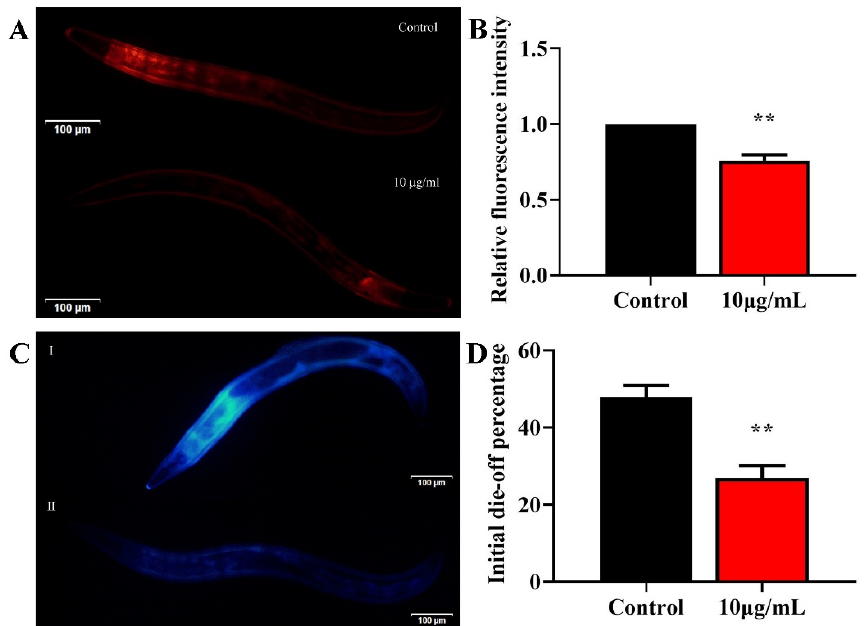
Figure 3. Effects of TG on the lipofuscin accumulation in C. elegans . ( A–D ) Worms were treated with TG for 8 days at 20 °C. Lipofuscin accumulation was measured using blue (Ex/Em 340/430 nm) and red autofluorescence (Ex/Em 546/600 nm). TG significantly reduced the lipofuscin accumulation in C. elegans . The data were analyzed using a Student’s t-test. The values were shown as the mean ± SEM, ** p < 0.01.